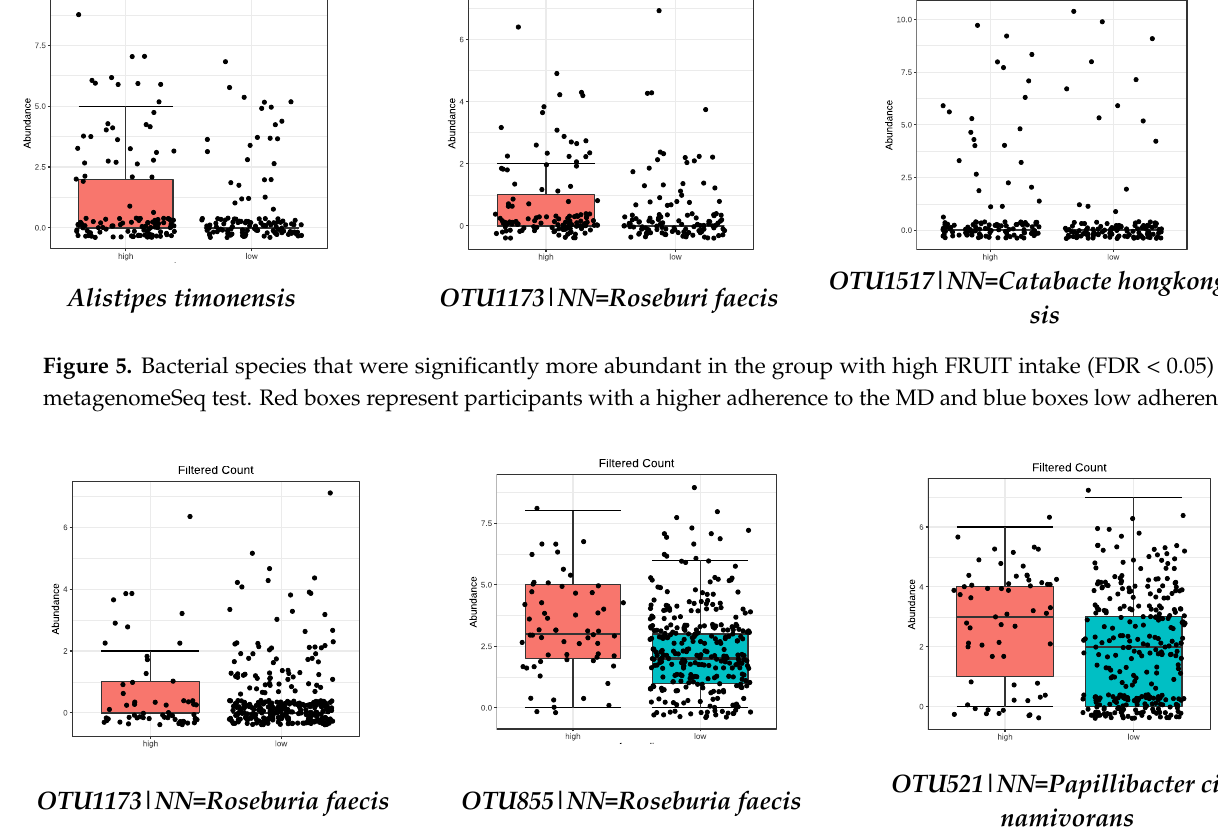
Figure 6. Bacterial species that were significantly more abundant in the group with high NUTS intake (FDR < 0.05) by metagenomeSeq test. Red boxes represent participants with a higher adherence to the MD and blue boxes low adherence.